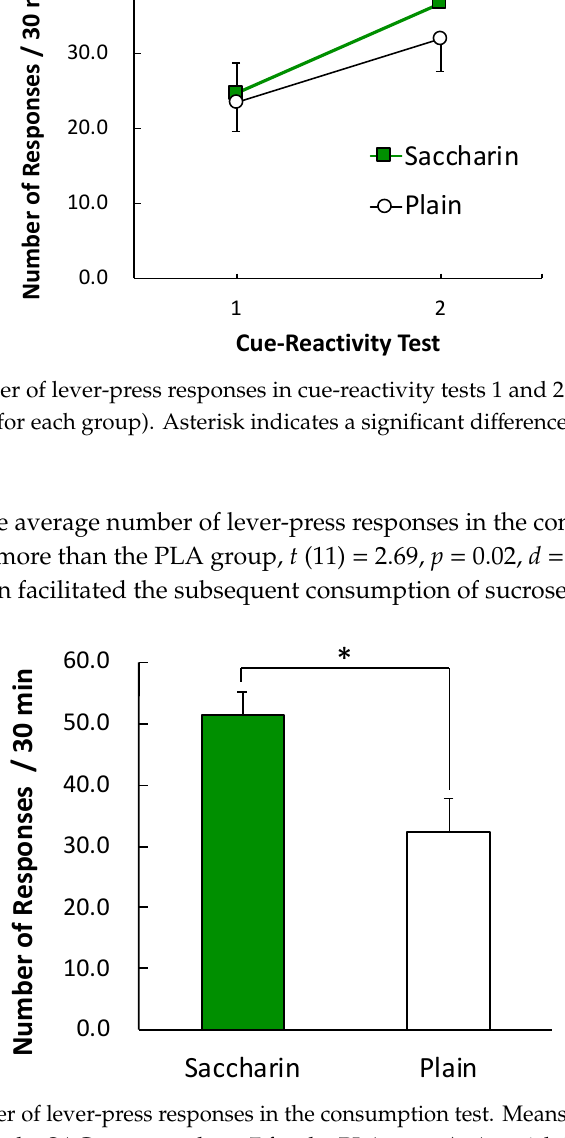
Figure 4. Mean number of lever-press responses in the consumption test. Means ± SEMs are indicated in the figure ( n = 6 for the SAC group and n = 7 for the PLA group). Asterisk indicates a significant difference between the groups.